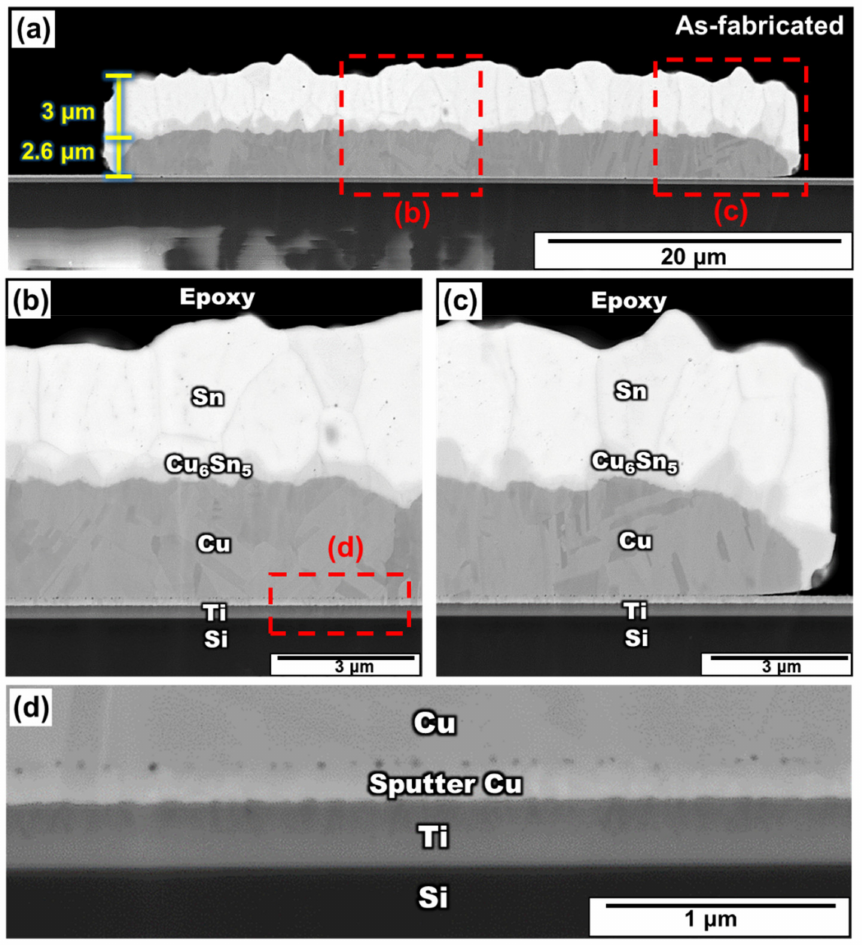
Figure 2. ( a ) Cross-section SEM image of the as-fabricated Sn/Cu micro-bump, and the zoomed-in image in a region near the ( b ) middle region, ( c ) right edge, and ( d ) interface between Cu and Ti